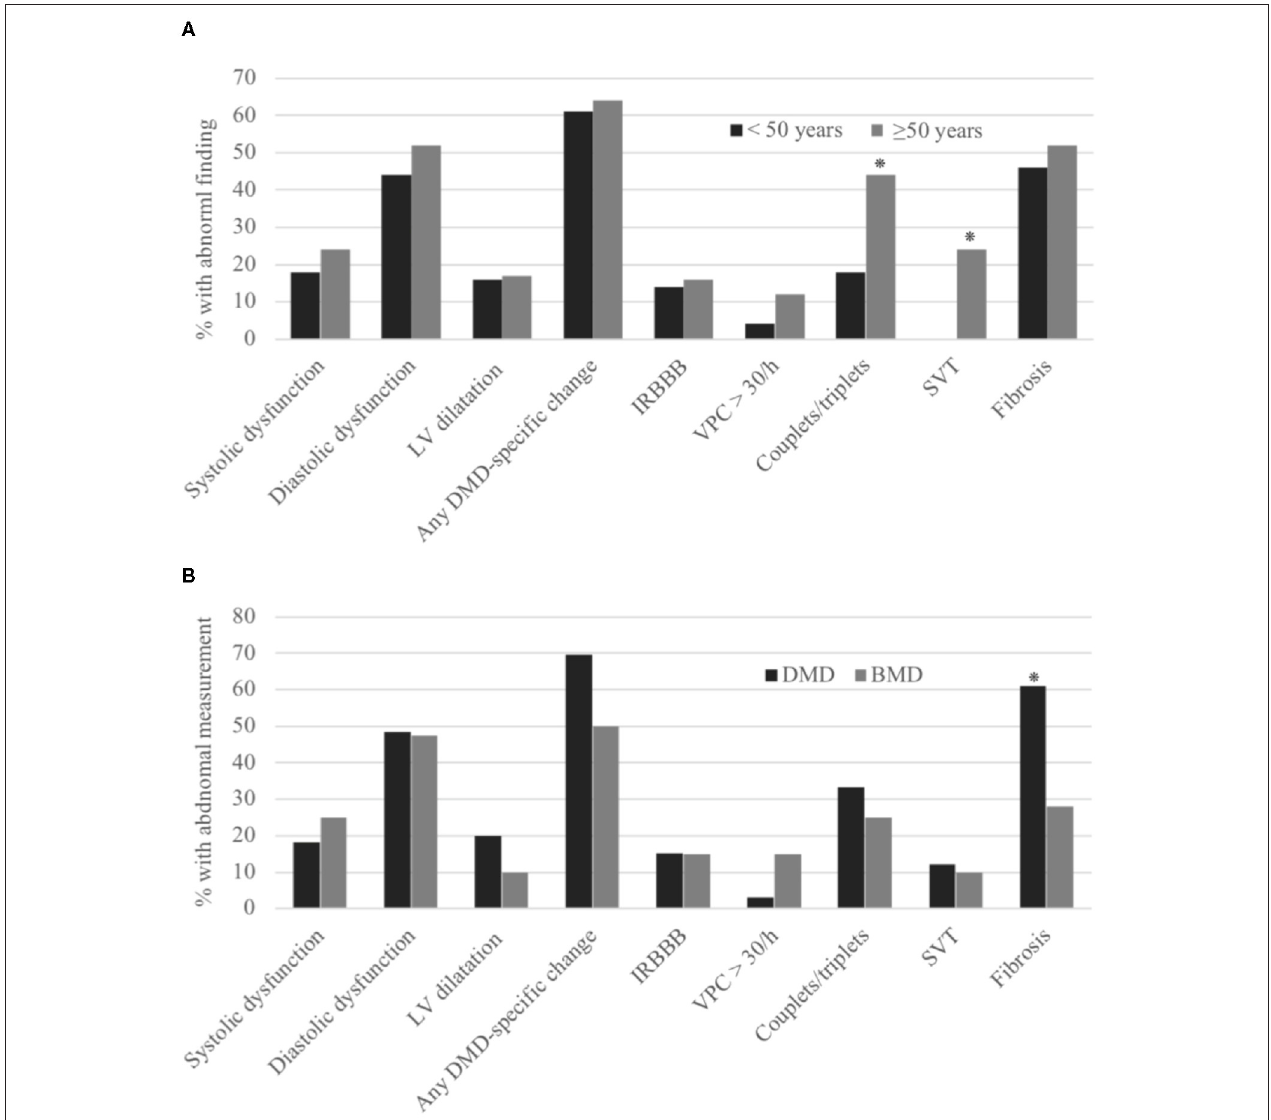
FIGURE 1 | Cardiac abnormalities in women with pathogenic DMD variants. Comparing women younger or older than 50 years (A) and women with pathogenic DMD variants predicted to cause Duchenne muscular dystrophy (DMD) and Becker muscular dystrophy (BMD) (B) . LV, left ventricle; IRBBB, incomplete right bundle branch block, VPC, ventricular premature contractions; SVT, supraventricular tachyarrhythmias. * p <